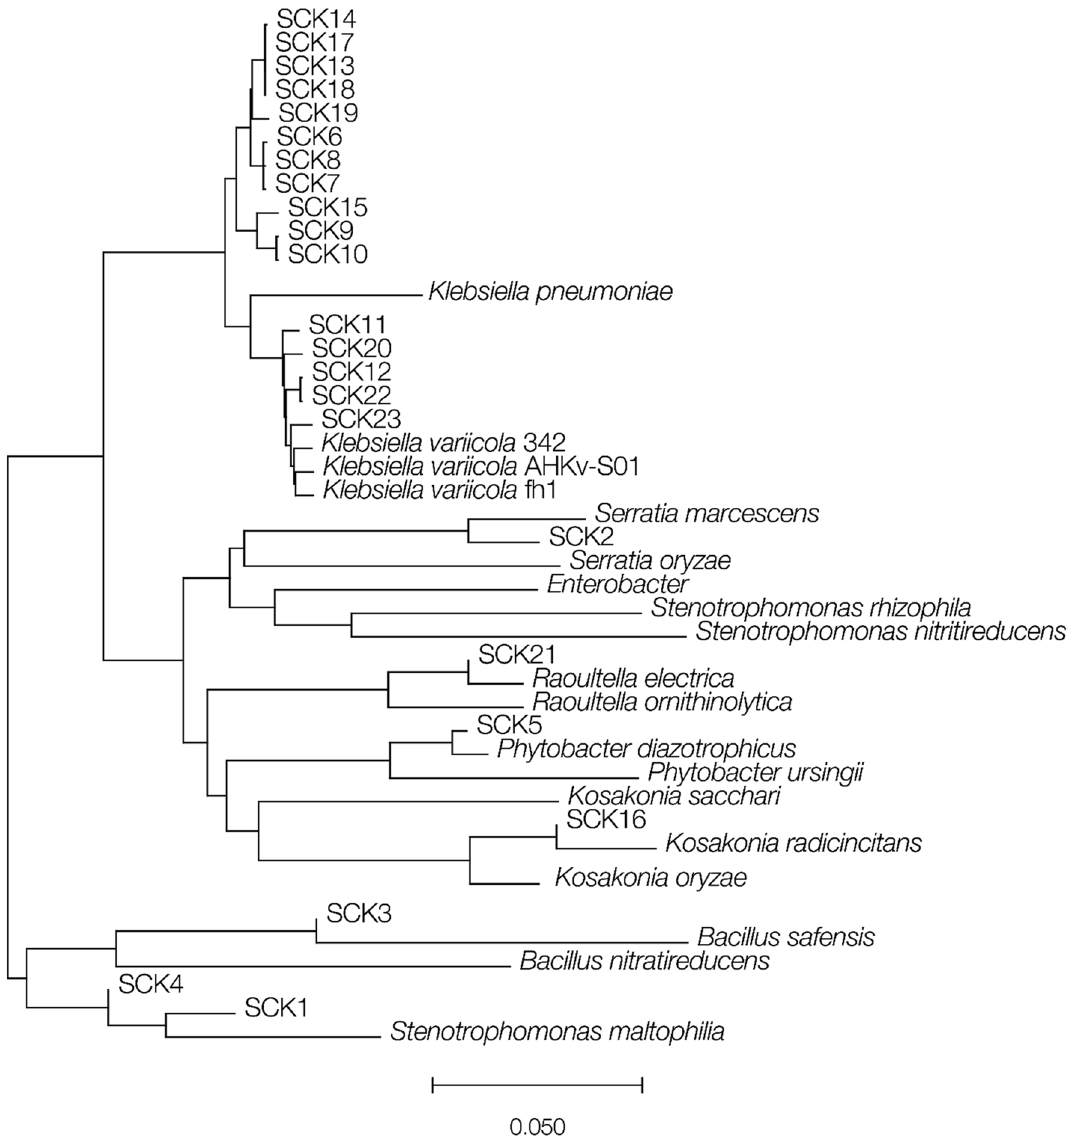
Figure 1. Phylogeny of the bacterial isolates characterized here (SCK numbers) together with their most closely related bacterial type strains. The phylogeny was reconstructed using pairwise average nucleotide identities between whole genome sequence assemblies, converted to p-distances, with the neighbor-joining method. Horizontal branch lengths are scaled according the p-distances as